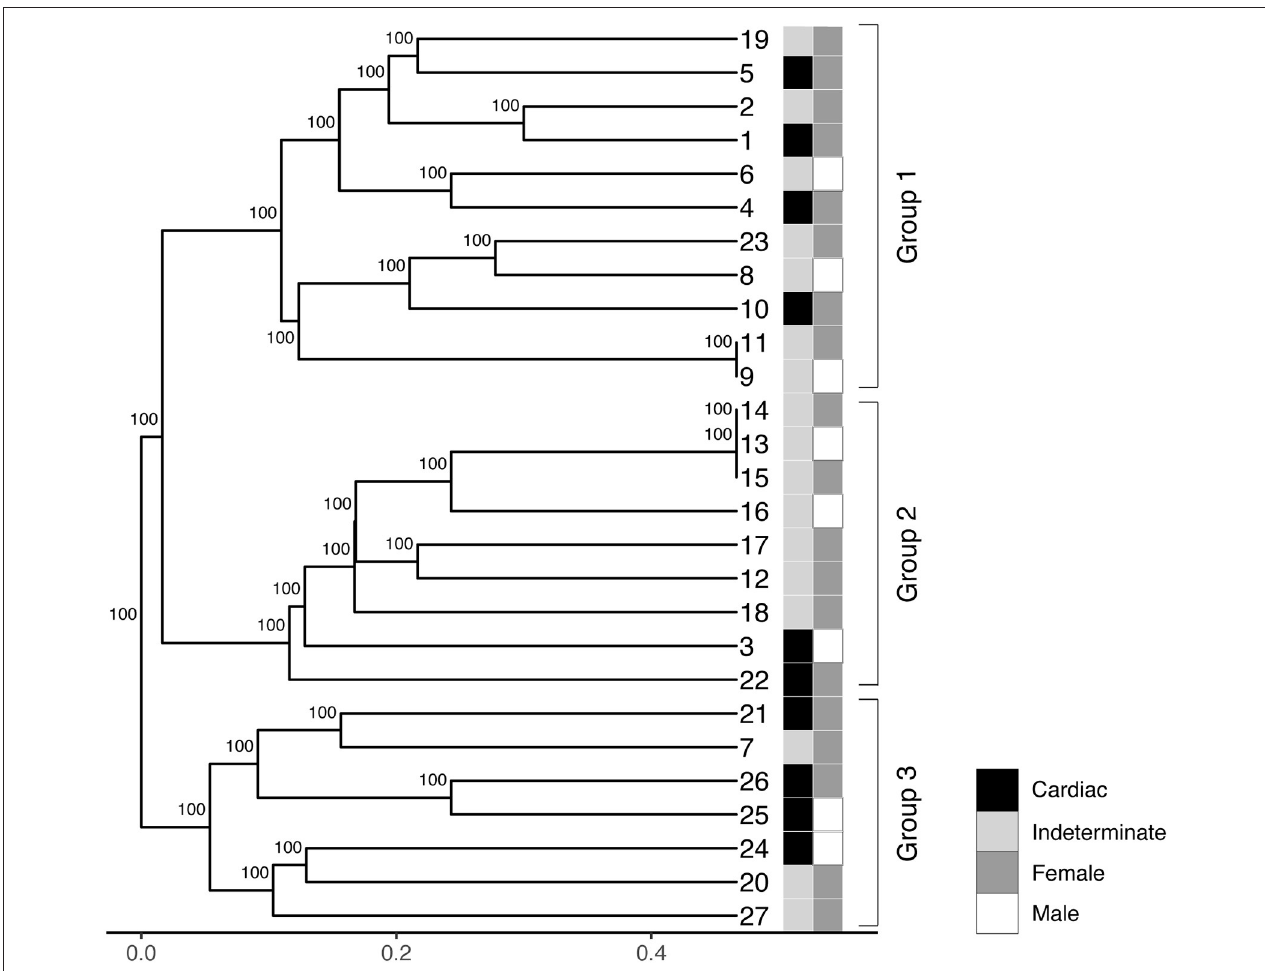
FIGURE 2 | Phenogram containing UPGMA (unweighted pair-group method analysis) of the 27 samples of T. cruzi belonging to DTU TcV. The numbers on the horizontal scale were obtained from the similarity coefficient of data. Different colors represent the clinical forms (indeterminate and cardiac) and gender of each patient (male or